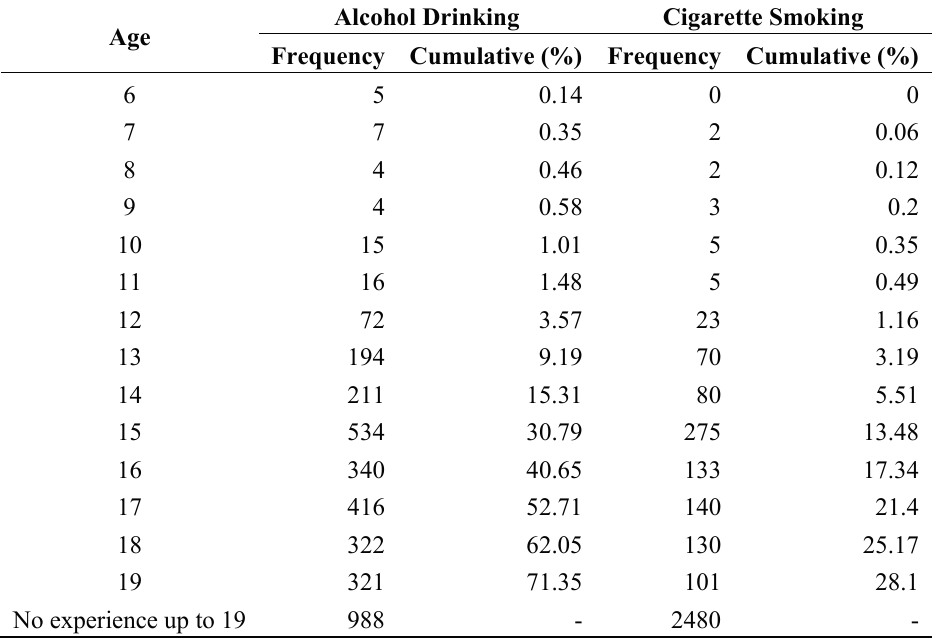
Table 3. Frequency and cumulative percentage of youth with experience of first-time substance use (N =